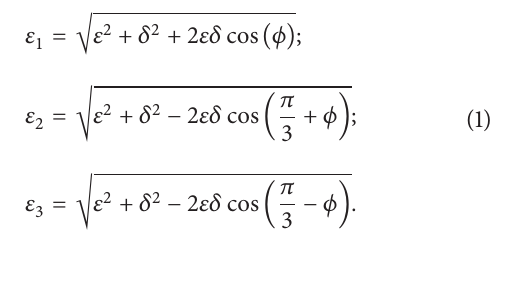
Figure 1: Three-lobe pressure dam bearing.